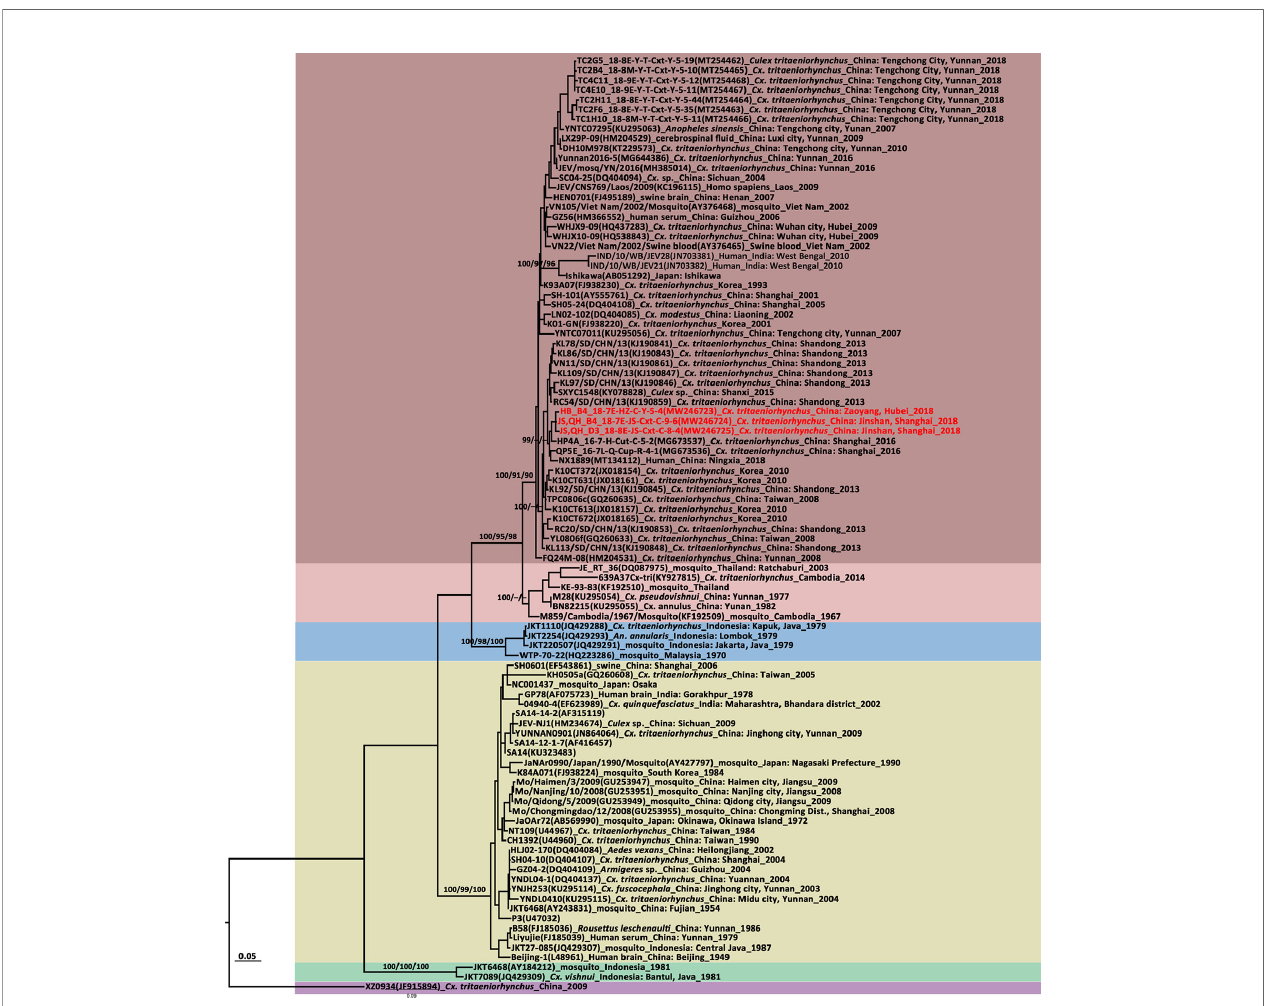
FIGURE 3 | Maximum likelihood phylogenetic analysis of Japanese encephalitis virus (JEV) envelope gene sequences. The virus strain, GenBank accession number, host, collection country and year are noted. The JEV sequences obtained in this study are marked in red. The numbers above each branch represent the bootstrap support of the maximum likelihood, neighbor-joining, and Bayesian analyses, respectively, based on 1,000 replicates. The scale-bar indicates 0.05 substitutions per site. Sequences shaded misty rose represent the GI-a genotype, those shaded rose-brown represent the GI-b genotype, those shaded sky blue represent the GII genotype, those shaded khaki represent the GIII genotype, those shaded aquamarine represent the GIV genotype, and those shaded thistle represent the GV